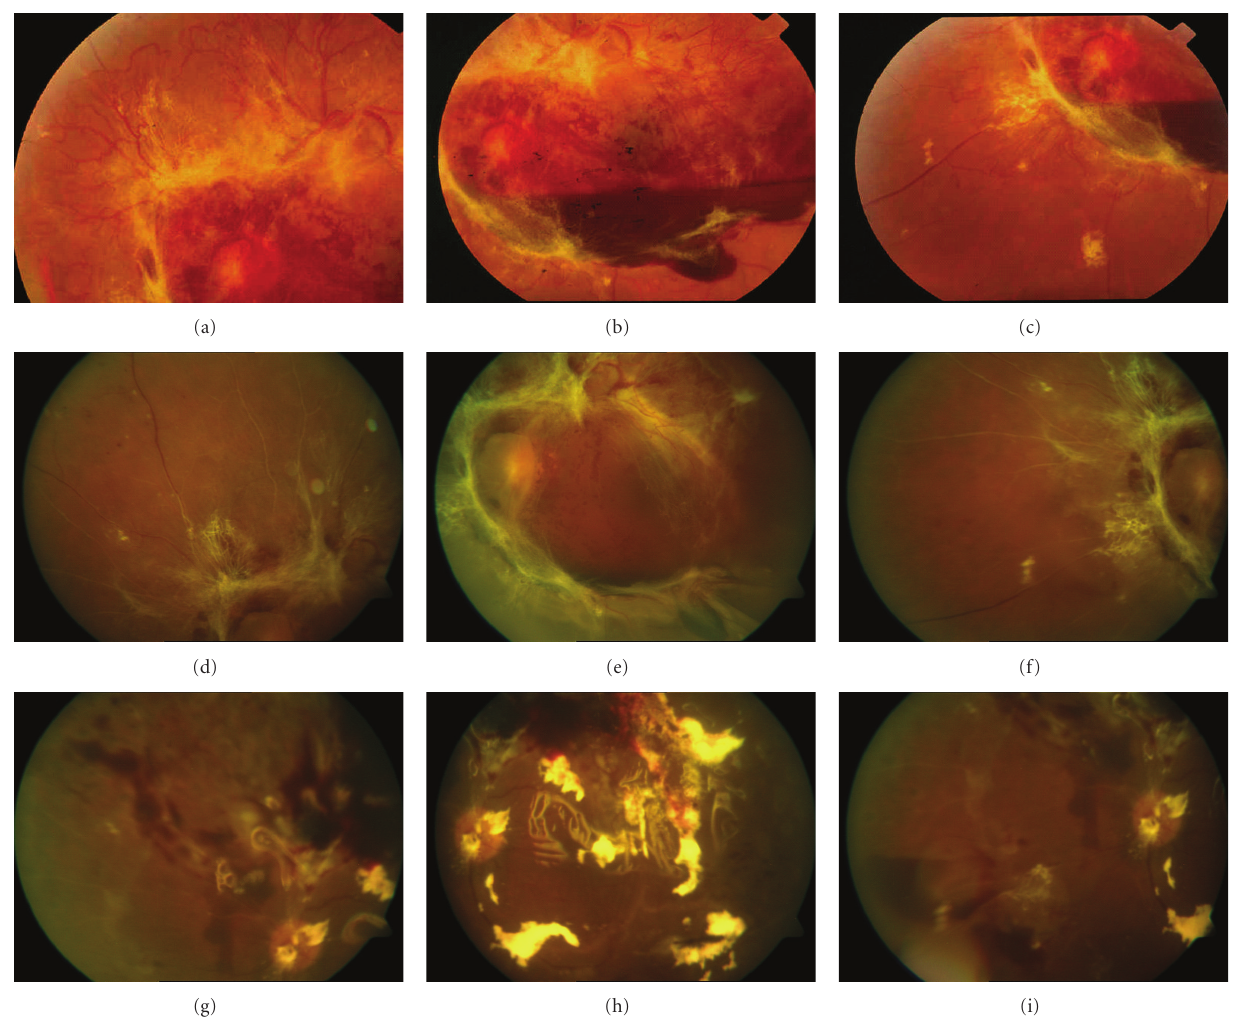
Figure 5: (a)–(c) Color photographs before intravitreal bevacizumab. Severe proliferative diabetic retinopathy with abundant fibrovascular tissue and subhyaloid hemorrhage. The retina is attached and best-corrected visual acuity (BCVA) is 20/80. (d)–(f) Color photographs 10 days after 2.5 mg of intravitreal bevacizumab demonstratingdense fibrous tissue contraction, and tractional retinal detachment with macular involvement. BCVA is hand motions at 2 meters. (g)–(i) Same eye, eight days after vitrectomy. The retina is reattached and best-corrected visual acuity (BCVA) is 20/120 with silicone oil